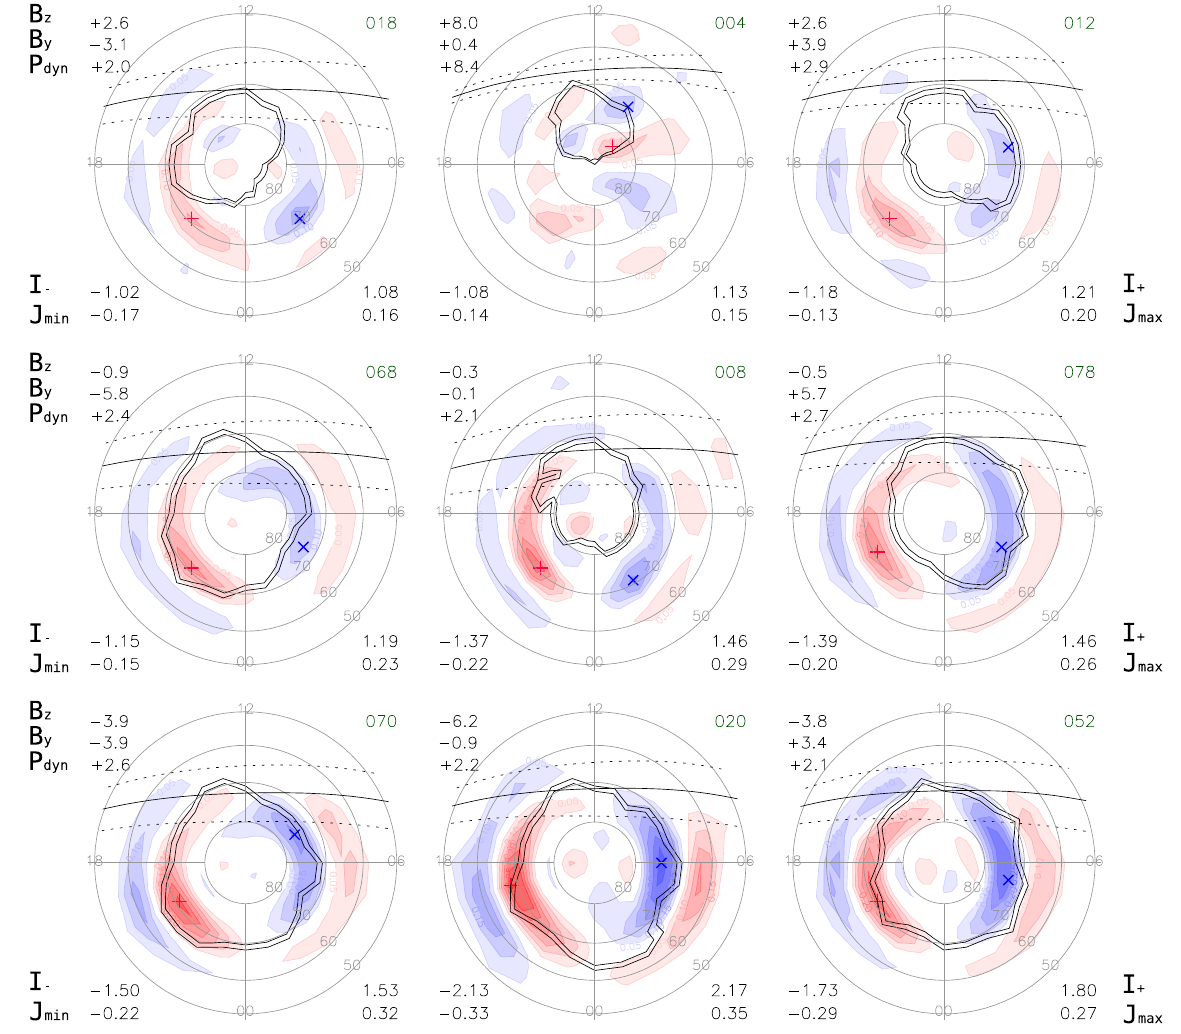
Fig. 6. Northern Hemisphere winter average field-aligned current distributions. For full figure description see Fig.